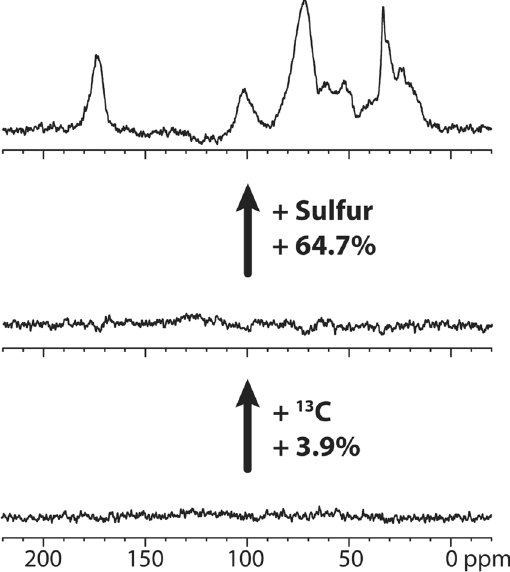
Figure 3. 13 C CP-MAS NMR difference spectra, showing the total carbon increase with 13 C labelling. A (control with no 13 C enrichment) to B (with 13 C enrichment), 3.9% and B to C (with 13 C enrichment and sulfur addition), 64.7%.